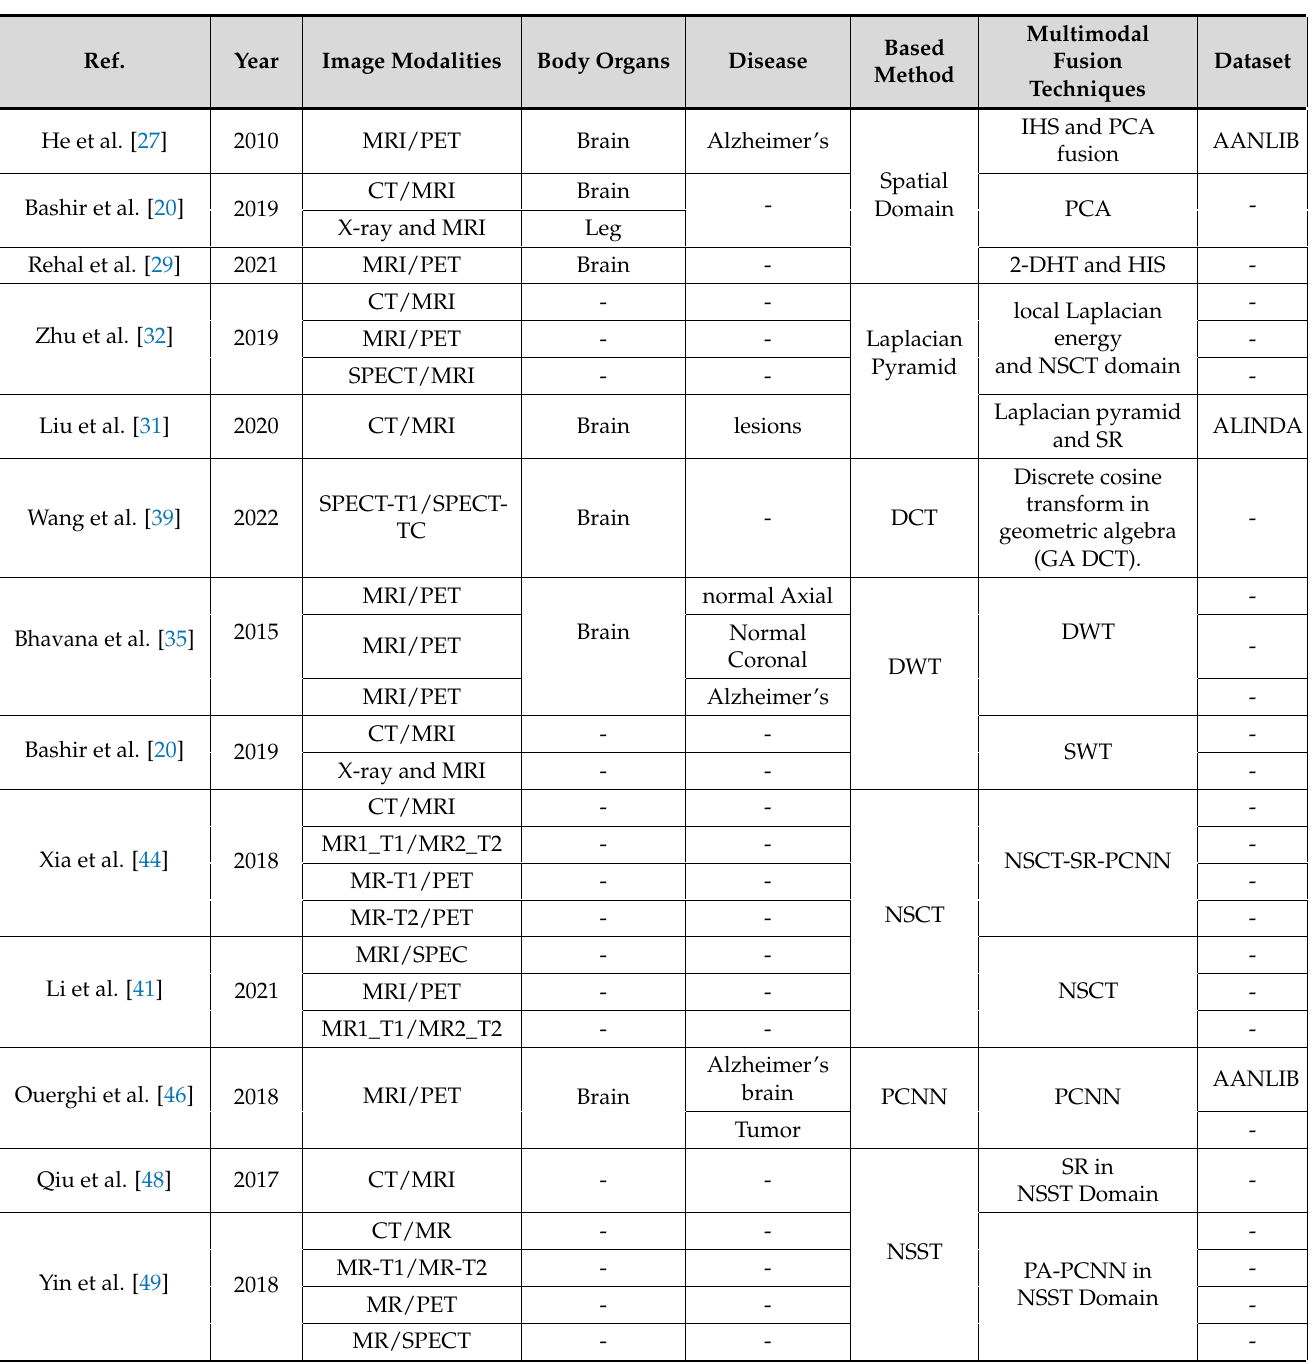
Table 2. MMIF technique classification and major contributions in research